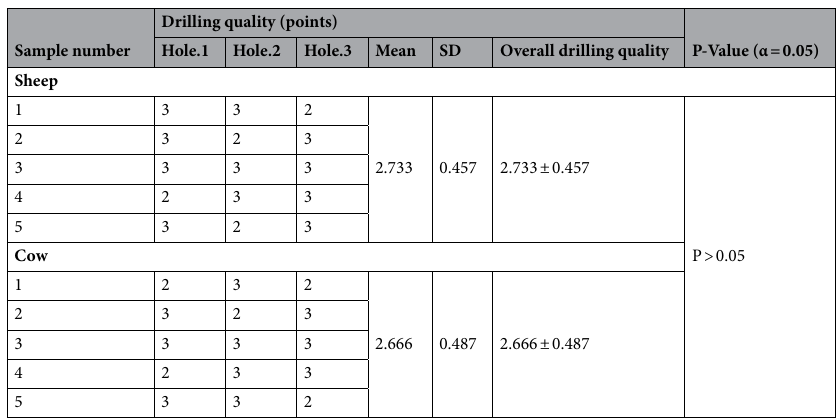
Table 2. The drilling quality points for each interlocking of IMN hole in sheep and cow samples.